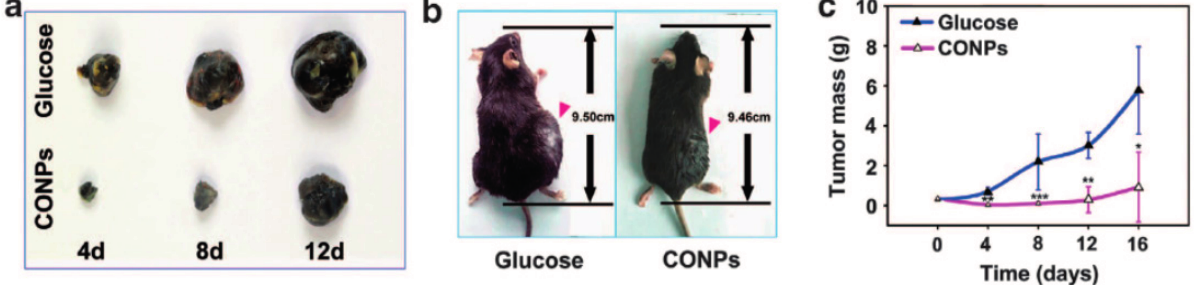
Figure 4. Antitumor effects of copper oxide NP (CONP) therapy on subcutaneous melanoma and metastatic lung tumors. ( a ) Representative images of stripped subcutaneous tumors; ( b ) Representative images of mice bearing subcutaneous melanoma from the same study at Day 12; ( c ) Plot of tumor mass versus time. Reproduced with permission from